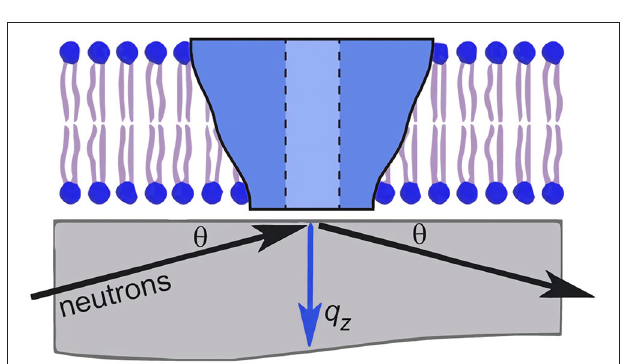
FIGURE 2 | Schematic of an neutron reflectometry (NR) experiment involving a single lipid bilayer with an integral protein adsorbed to a solid support (usually single crystal Si). An incident beam of neutrons is transmitted through the substrate and is reflected from the different interfaces of the sample. The scattering vector, q z , is denoted by the blue arrow. The detection and analysis of the reflected beam allows for the determination of the one-dimensional SLD along the bilayer normal. Figure was adapted from Soranzo et al.